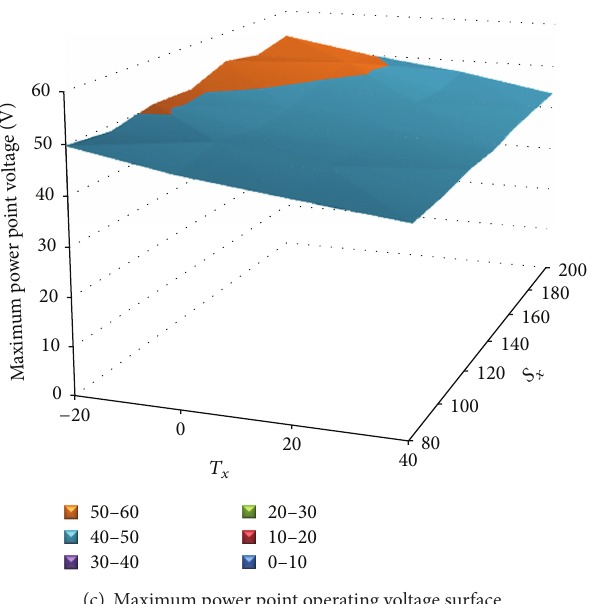
Figure 10: Maximum power point surfaces under variable solar irradiation and temperature levels with fixed sizing. (a) Maximum power point surface, (b) maximum power point operating current surface and, (c) maximum power point operating voltage